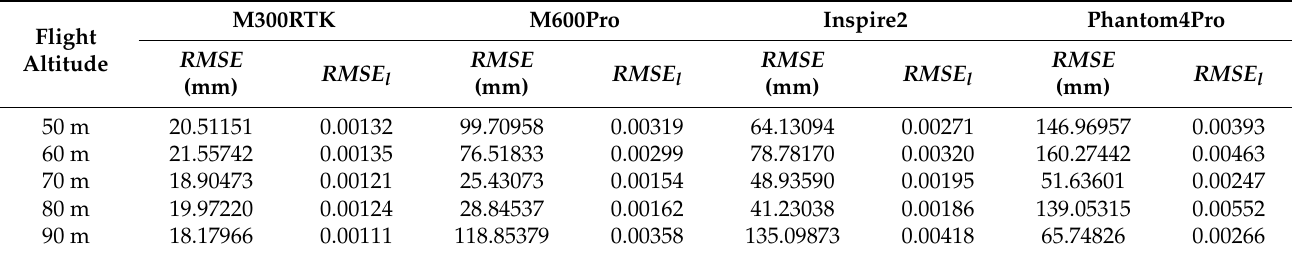
Table 5. Accuracy comparison of the 3D